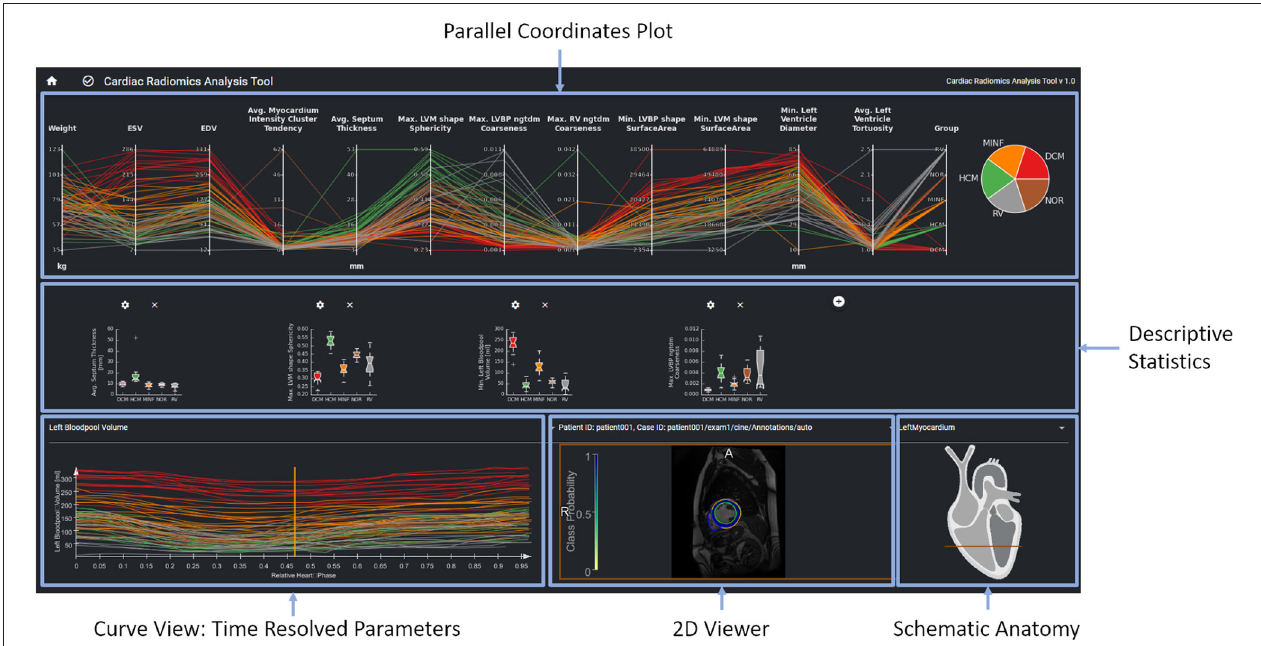
FIGURE 3 | The parallel coordinates plot in the top row shows multi-dimensional data as line sets. Each y-axis represents a specific parameter. The diagrams in the center row show distributions and correlations of selected parameters. The curve view on the bottom left supports the exploration of the temporal dynamics of a selected parameter over the cardiac cycle The image data, the curve parameter of the selected timepoint is based on is displayed in the image viewer on the bottom right. Contours and overlay show the segmentation as well as the local certainty of the segmentation